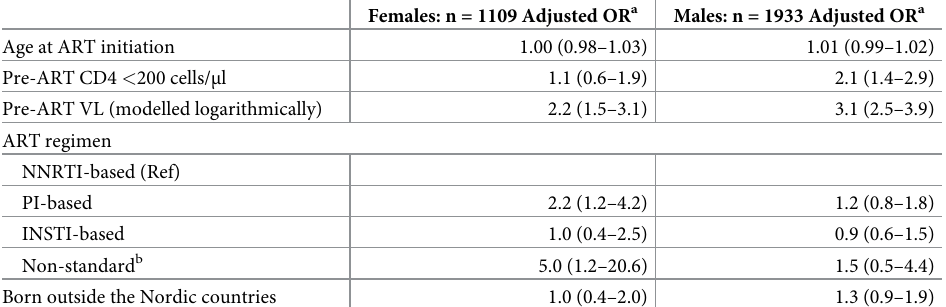
Table 3. Association between low-level viraemia and pre-ART CD4 count, pre-ART viral load and type of ART, stratified by